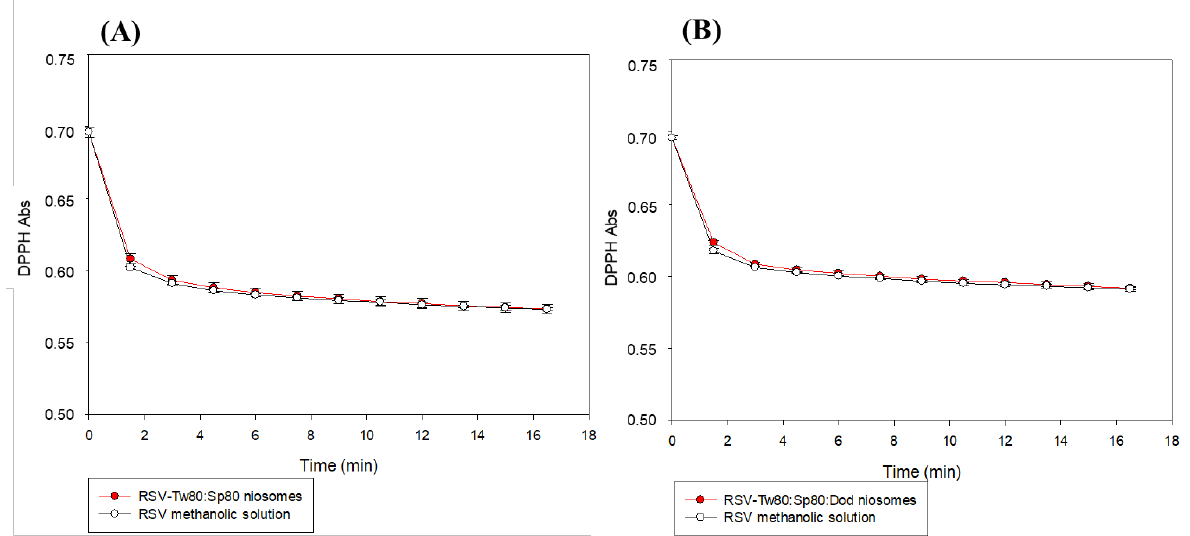
Figure 2. DPPH absorbance vs. time for ( A ) Tw80:Sp80 and ( B ) Tw80:Sp80:Dod niosomes, loaded with RSV, and a control solution in methanol. [RSV] = 3 µ M. Error bars correspond to standard deviations of at least three